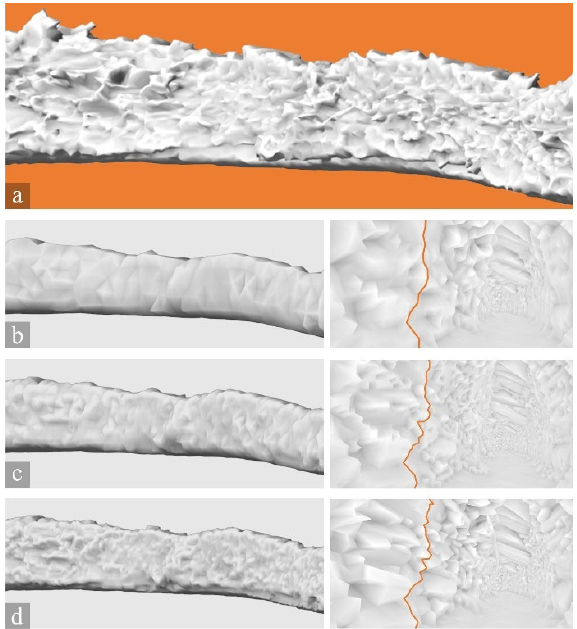
Figure 8. The gradual recovery of details applying the shrink wrap modifier in Blender. High-poly model raw with 20M faces (a), and re-topologized low-poly models with: ~ 15k faces (b), ~ 60k faces (c) and ~ 240k faces (d).